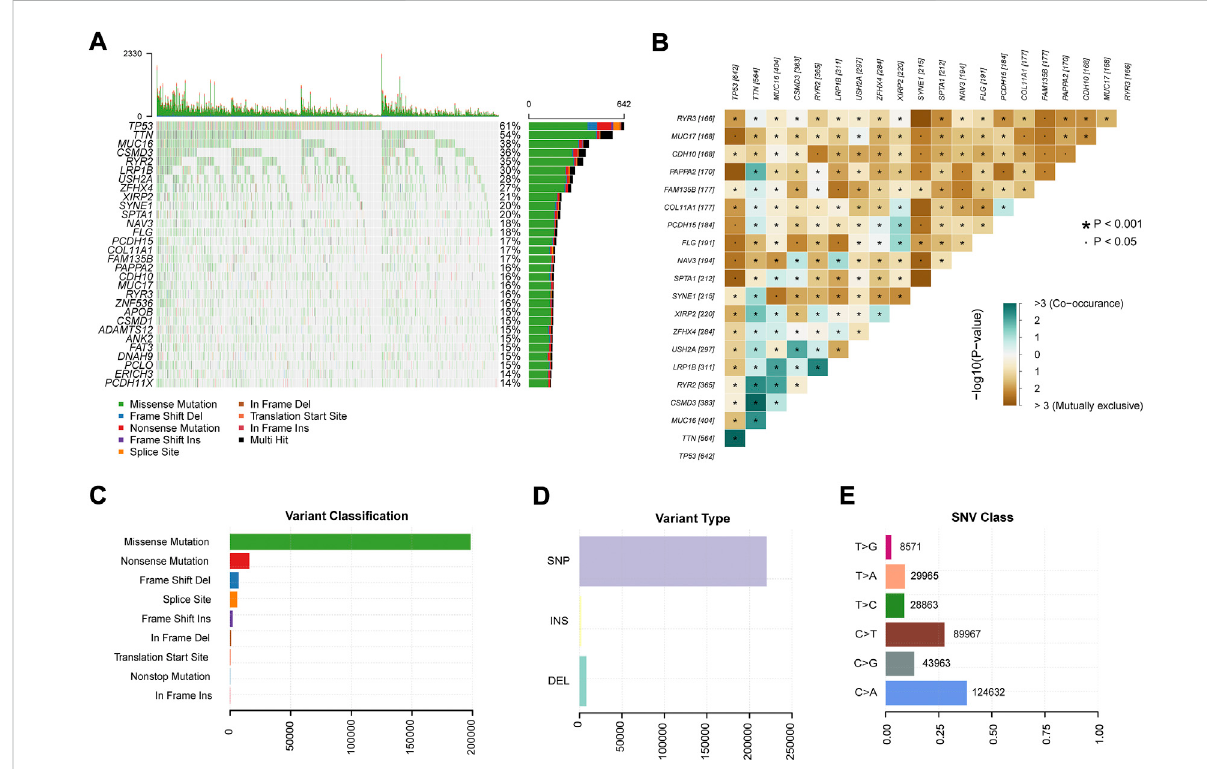
FIGURE 2 Summaryofmutationpro fi lesinNSCLC. (A) Waterfallplotsshowedthemutationsforeachgeneineachsample. (B) Co-occurrenceandmutual exclusion of genes with genomic alterations in NSCLC. (C) Missense mutations accounted for the largest proportion of the nine variant mutation forms in the sample. (D) SNPs were the most frequent of the three variant types in all samples. (E) C > A transition was the most frequent of the six subclasses of SNPs. SNP: single nucleotide